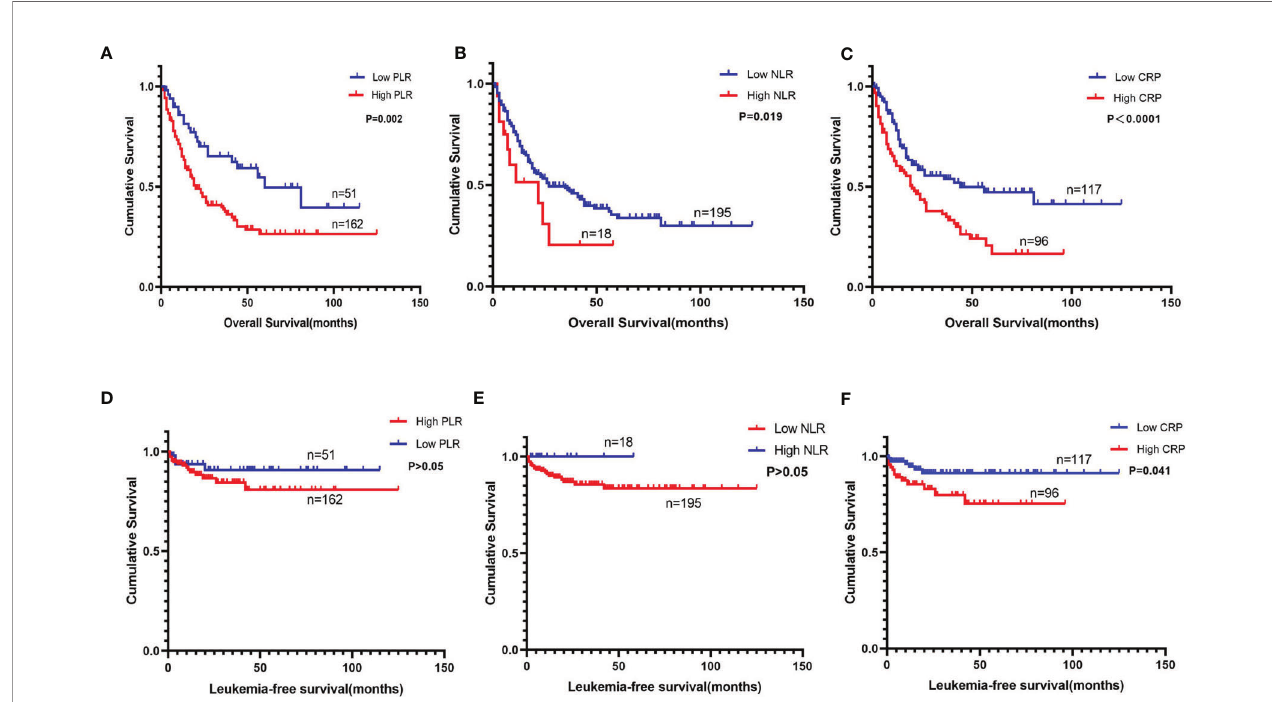
FIGURE 2 | Overall survival and leukemia-free survival of myelodysplastic syndrome (MDS) patients according to the strati fi ed analysis of platelet-to-lymphocyte ratio (PLR), neutrophil-to-lymphocyte ratio (NLR), and C-reactive protein (CRP). (A) Overall survival of 213 patients with primary MDS was strati fi ed by PLR ≤ 22.14 vs. PLR >22.14 ( P = 0.002). (B) Overall survival of 213 patients with primary MDS was strati fi ed by NLR ≤ 3.75 vs. NLR >3.75 ( P = 0.019). (C) Overall survival of 213 patients with primary MDS was strati fi ed by CRP ≤ 5 mg/L vs. CRP >5 mg/L ( P < 0.0001). (D) Leukemia-free survival of 213 patients with primary MDS was strati fi ed by PLR ≤ 22.14 vs. PLR >22.14 ( P > 0.05). (E) Leukemia-free survival of 213 patients with primary MDS was strati fi ed by NLR ≤ 3.75 vs. NLR >3.75 ( P > 0.05). (F) Leukemia-free survival of 213 patients with primary MDS was strati fi ed by CRP ≤ 5 mg/L vs. CRP >5 mg/L ( P = 0.041).